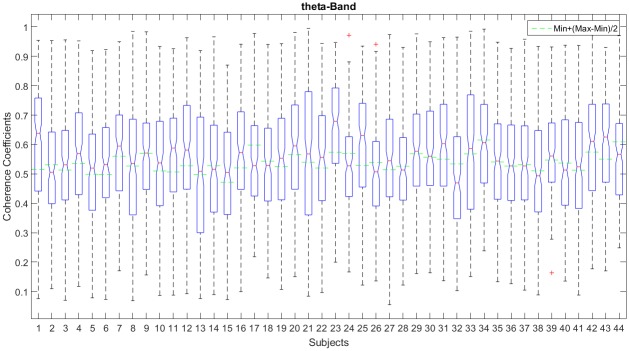
An example of the coherence coefficients distribution (CCD) by subject in θ band.The boxplots per subject indicate the 2nd and 3rd quartiles (blue box) which contain 50% of the sample, whiskers contain the 25% of lower and higher coherence values of the sample, the red line indicates the median value, and the green line represents the threshold which lies mostly in the 2nd and 3rd quartiles, taking into account more or less the 50% of the coherence values sample.